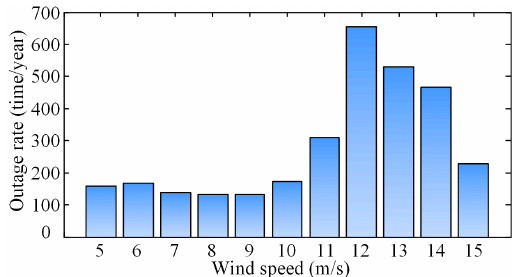
Figure 16. Relationship between WT outage rate and wind speed.